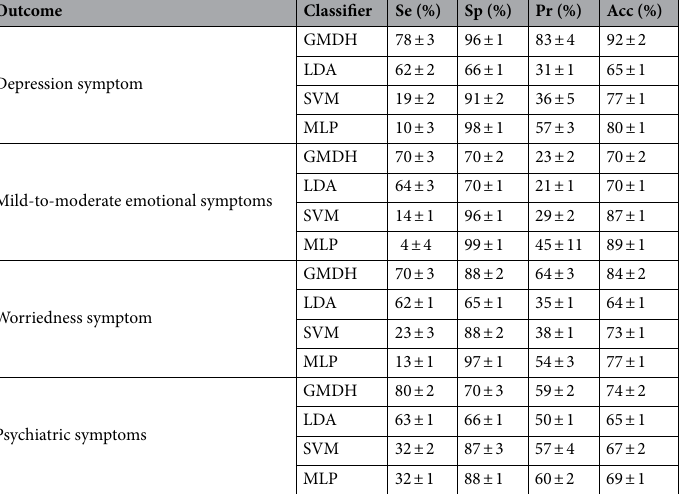
Table 3. The performance of the different classifiers in MEAN ± SD over the test folds using threefold cross- validation. Se Sensitivity, Sp Specificity, Pr Precision, Acc Accuracy.